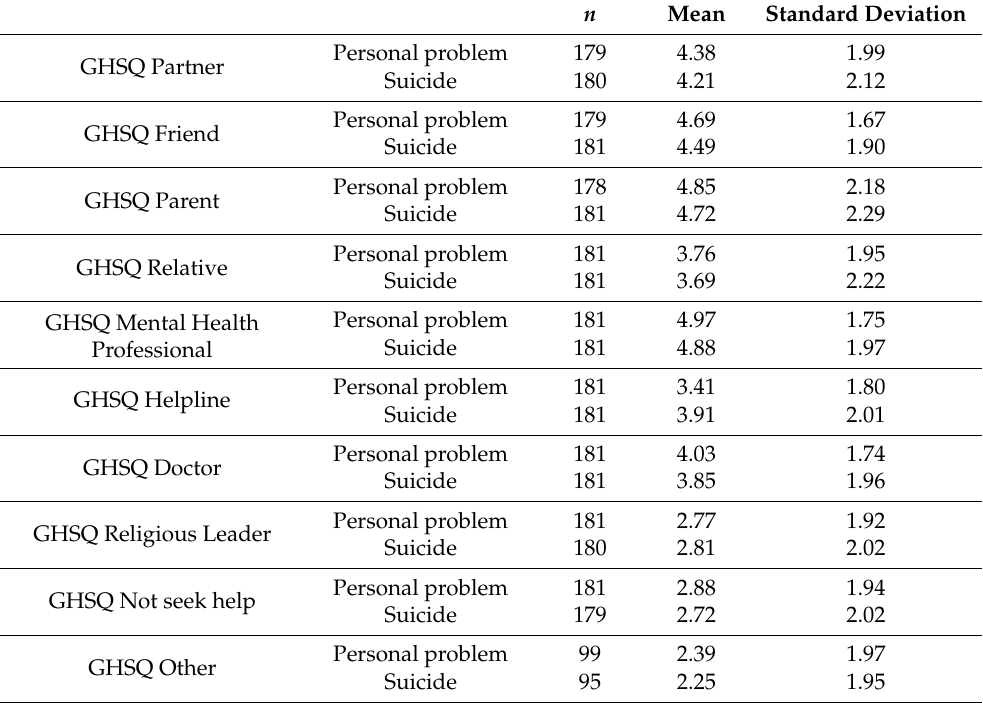
Table 1. Help-seeking